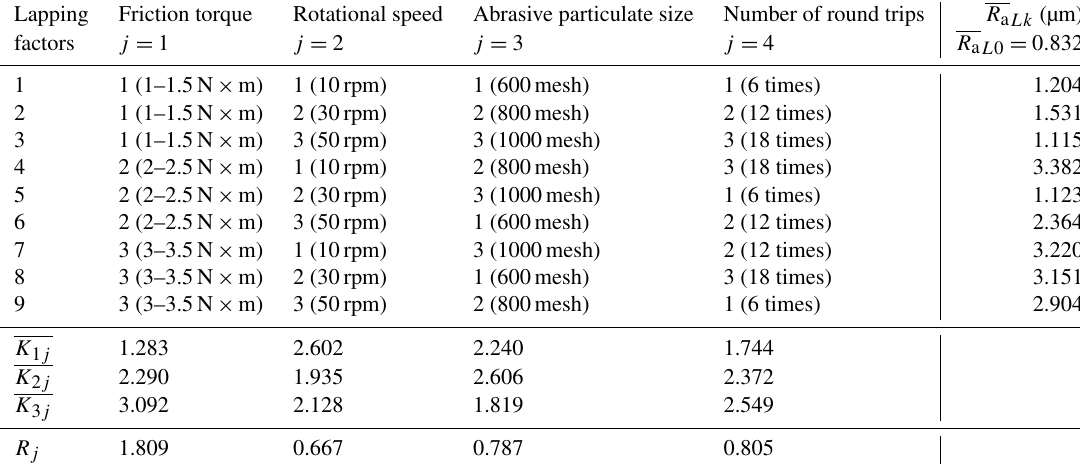
Table 4. Surface roughness of left arc. Lapping Friction torque Rotational speed Abrasive particulate size